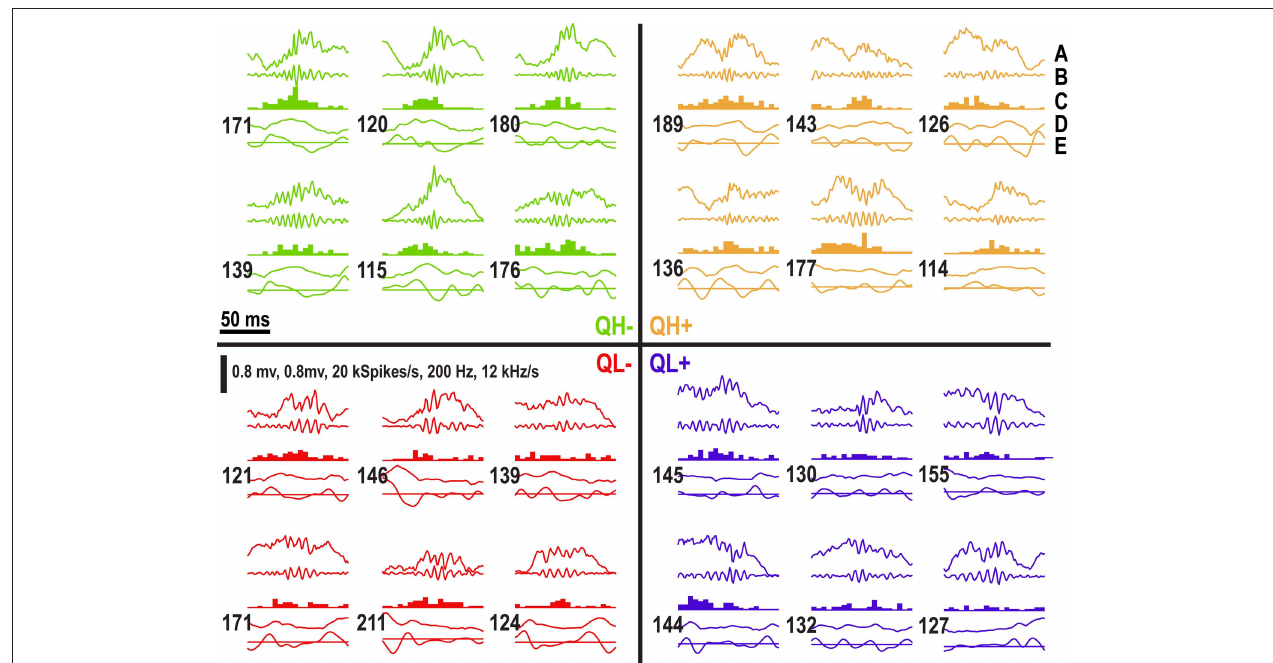
each ripple event. The number shown next to the iFreq estimate is the value of iFreq at the beginning of the trace. The horizontal line through the FM signal is the zero line.